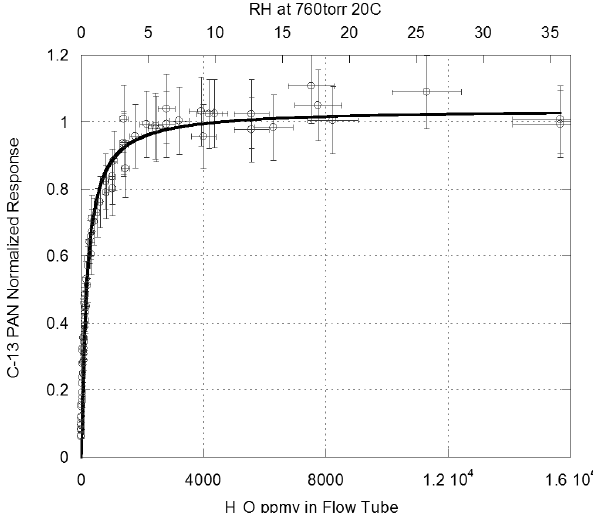
Fig. 12. The sensitivity of the TD-CIMS instrument to 13 C PAN as a function of absolute water concentration in the flow tube. Individual PAN measurements are shown as open circles with error bars of 10%. The curve is a hyperbolic fit to the